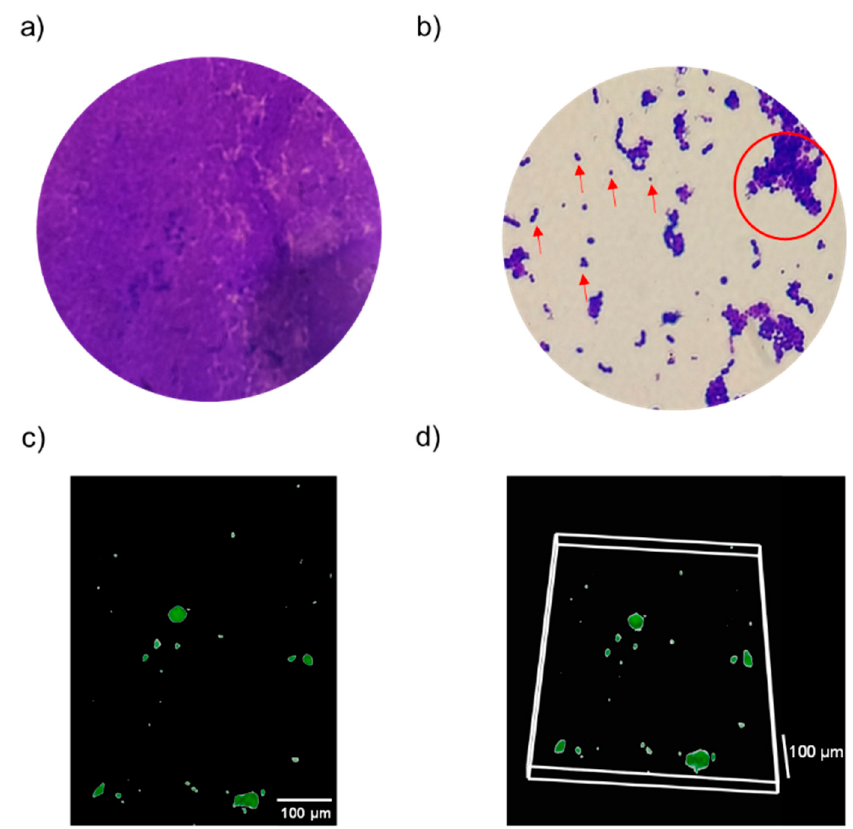
Figure 8. ( a ) Optical microscopy image of the S. aureus biofilm in the absence of NPs (100×), and ( b ) optical microscopy (100×), ( c ) fluorescence microscopy images XY plane, and ( d ) 3D reconstruction after inhibition of biofilm development with 2-MSN-Sn (250 μ g/mL). Excitation wavelength 490 nm and emission wavelength 519 nm. Red arrows indicate individual bacteria and red circle indicate biofilm fragments.